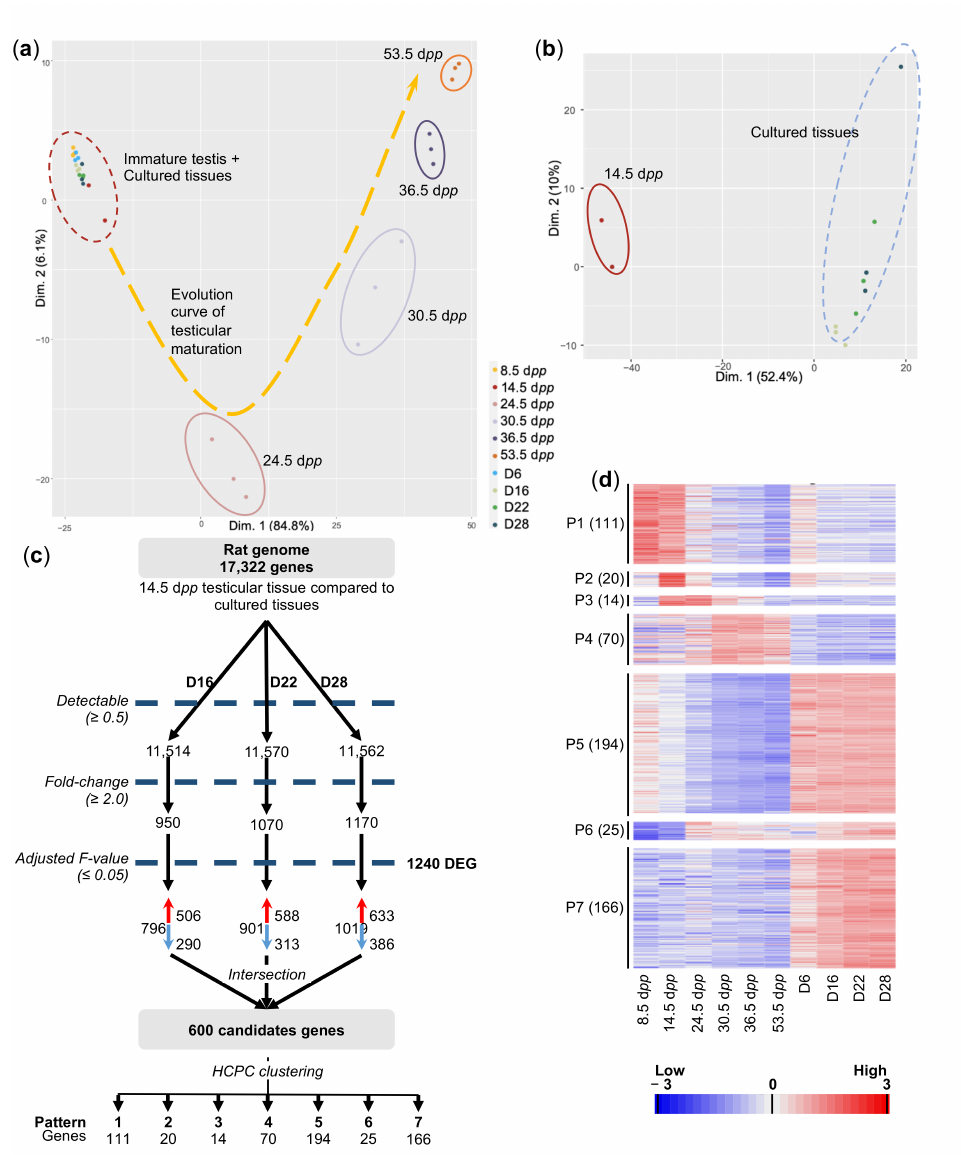
Figure 3. Transcriptomic analyses of in vitro and in vivo testicular tissues. ( a ) Scatter plot representing the position of each sample along the first two dimensions. Each point represents the average expression level of transcripts, one dot per replicate. The variability between samples is mainly explained by their age of development (Dimension 1, 84.8%). The different clusters, represented by colored circles, highlight the distance between each group of transcriptomes. An evolution curve of the transcriptome of maturing testicular tissues is represented in yellow. ( b ) PCA analysis conducted on the red dotted circle is shown in panel A, corresponding to cultured tissues and 14.5 dpp immature testes. The variability between groups is mainly explained by the origin of the tissue (in vivo vs. in vitro). All the in vitro-matured tissues display similar transcriptomic profiles. ( c ) Flowchart summarizing the filtration and clustering strategies. The numbers below the cluster ID indicate the genes falling into each cluster. ( d ) A false-color heatmap summarizes the seven patterns defining the global concentrations for transcripts across the entire sample set. Each line corresponds to a gene and each row to the mean expression value of a replicate. P1 to P7 refer to the number of patterns, followed by the number of genes included in each pattern in parenthesis. A color scale is shown for standardized values in RPKM, per million mapped reads. n = 3. Dpp—days post-partum; HCPC—hierarchical clustering on principal components; RPKM—reads per kilobase of